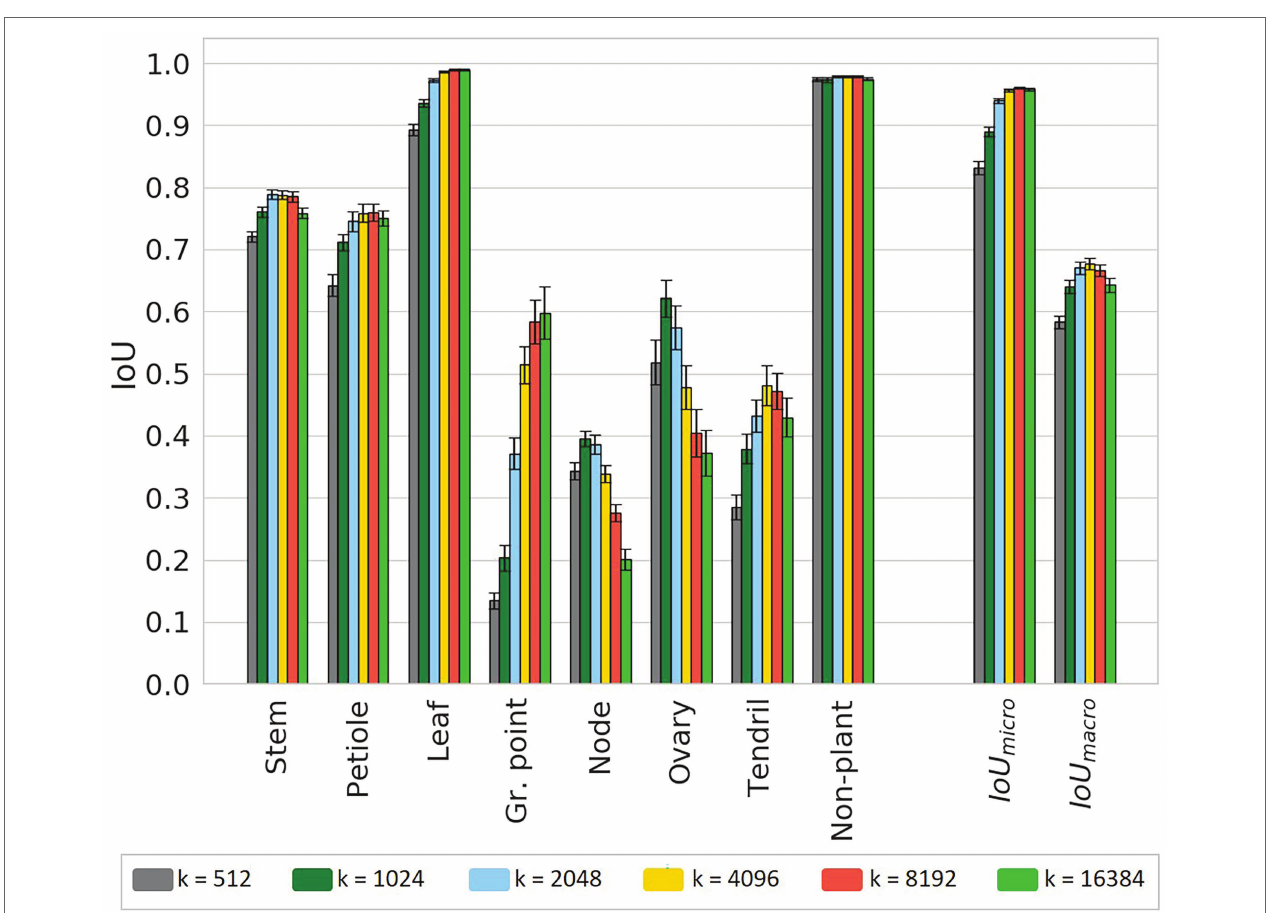
FIGURE 9 | IoU for the test set using six different chunk sizes, based on the class-dependent sampling strategy. Bars indicate the mean IoU and the error bars give the 95% confidence interval on the mean. The significance of differences between the observed IoU values are reported separately in Table A1 in Appendix A for readability.